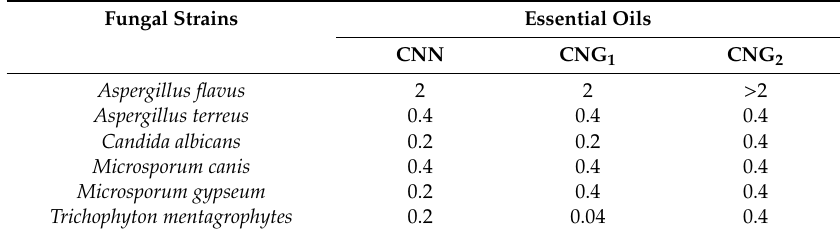
Table 3. Antifungal properties of essential oils produced by hydrodistillation of Clinopodium